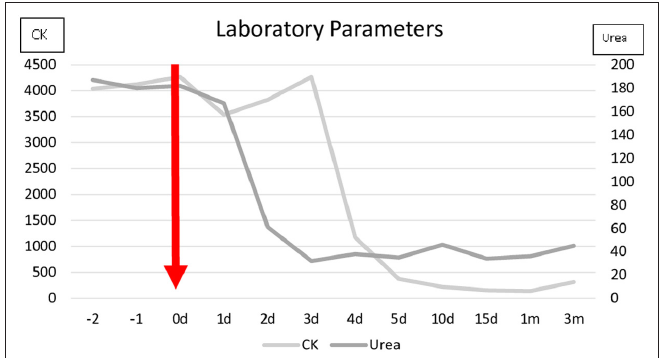
Figure 2. Creatine kinase and urea values of the patient before and after transplantation (black arrow marks the day of